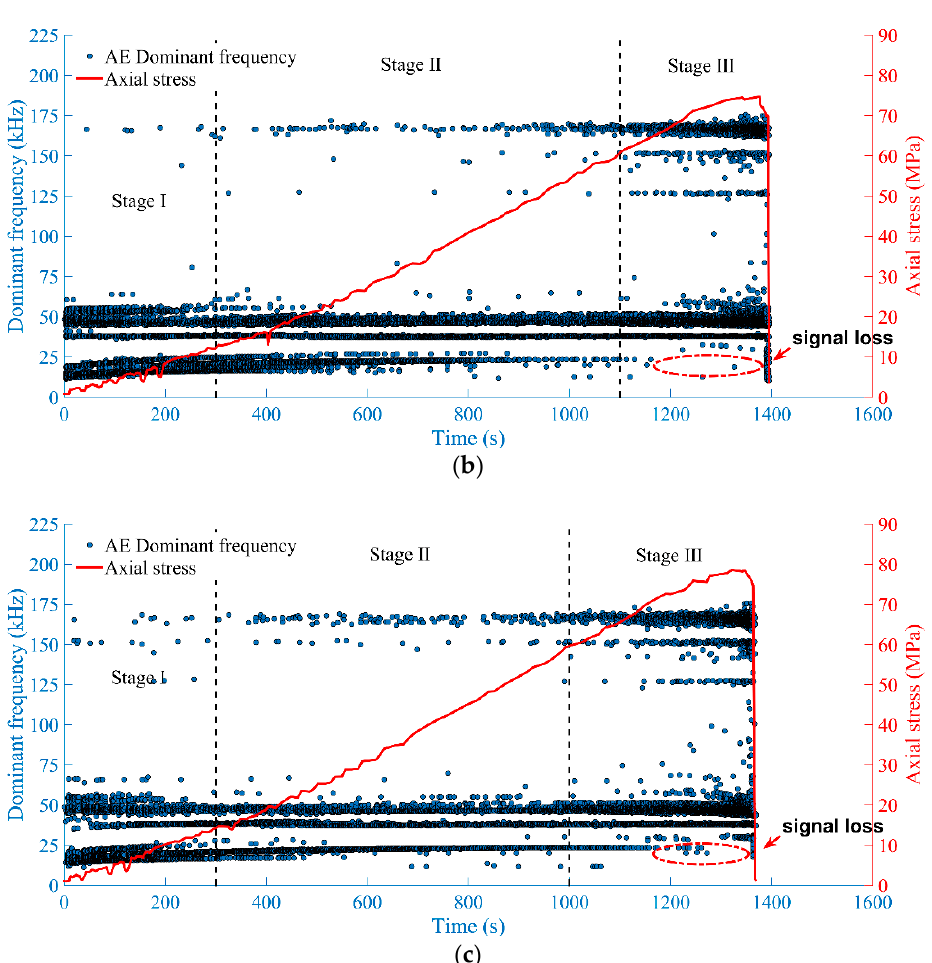
Figure 3. Relationship curves of time with AE dominant frequency and axial stress in the entire test process. ( a ) X-1 specimen; ( b ) X-3 specimen; and ( c ) X-6 specimen.